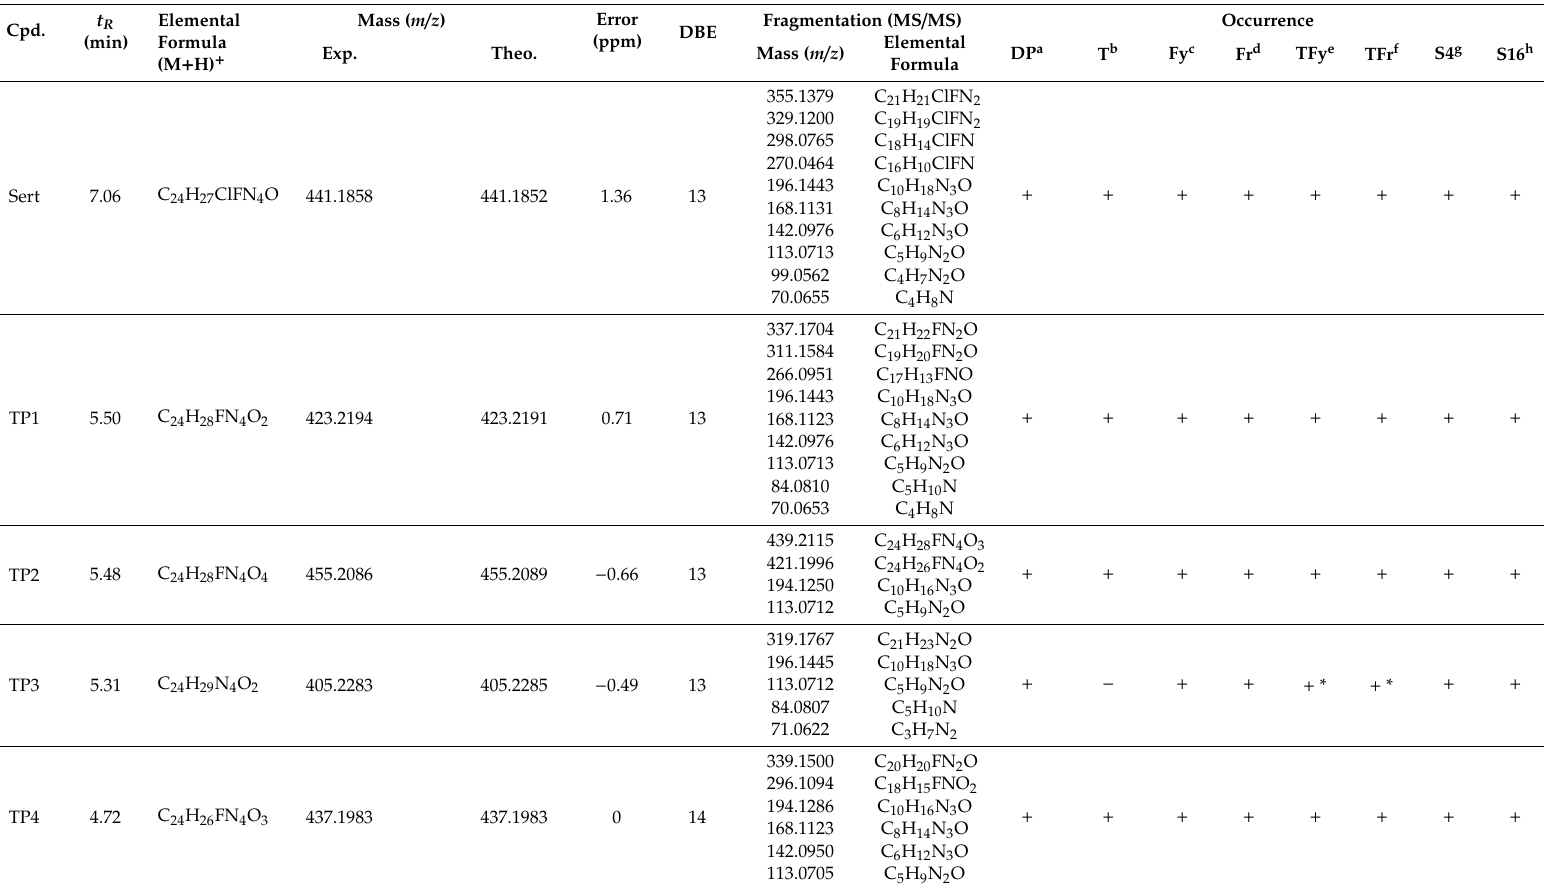
Table 3. Accurate masses of sertindole phototransformation